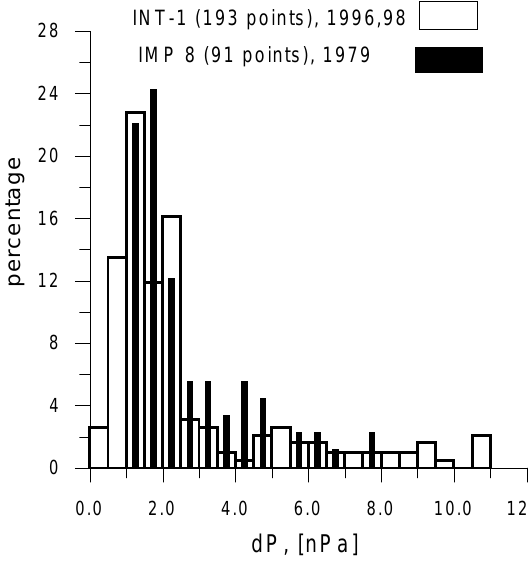
Fig. 1. An example of large and sharp pressure changes on 10 March 1998.